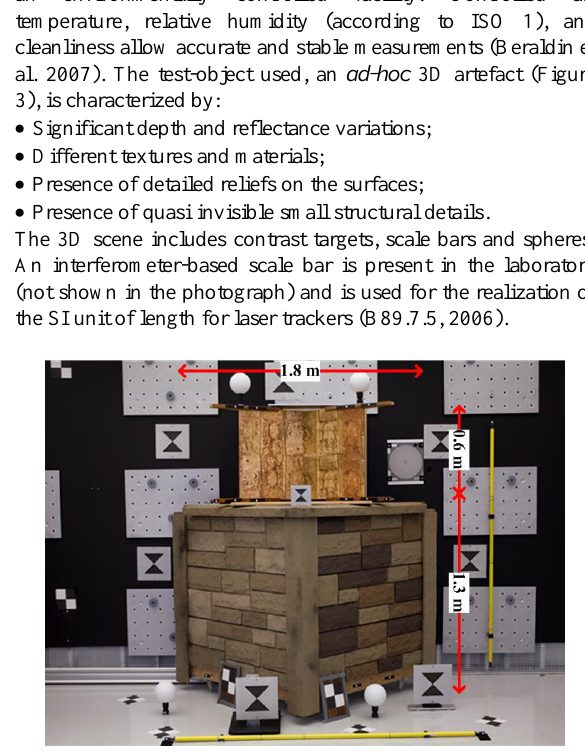
Figure 3. Test-object and dimensions (ISO1 Laboratory)